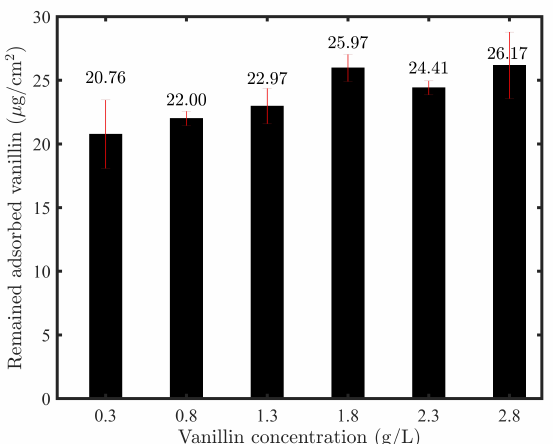
Figure 6. The amount of vanillin remaining on the surface and structure of modified membranes at the end of